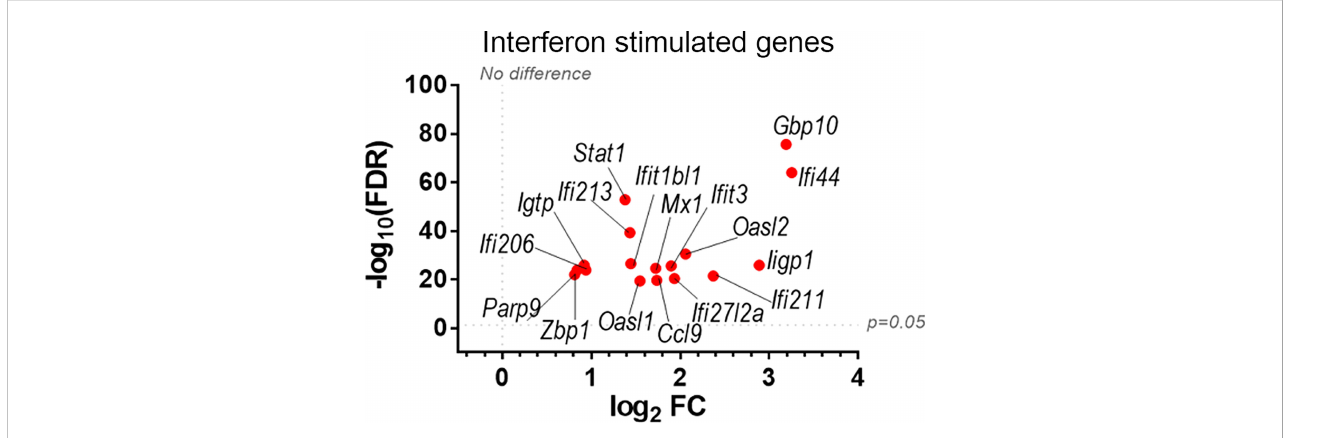
FIGURE 5 Upregulation of ISGs transcripts in NK cells from VACV-infected mice compared to mock. C57BL/6 mice ( n =4) were infected with VACV WT or were mock-infected. At 6.5 d.p.i., NK cell transcriptional changes were analysed by RNA-seq, and differential expression (VACV vs mock) was calculated for each gene. Seventeen ISGs were found out of the 100 most signi fi cantly altered transcripts (VACV vs mock (FDR<0.05)) and are depicted here. Each dot represents the differential expression of an ISG transcript (WT vs mock). Red indicates statistical signi fi cance